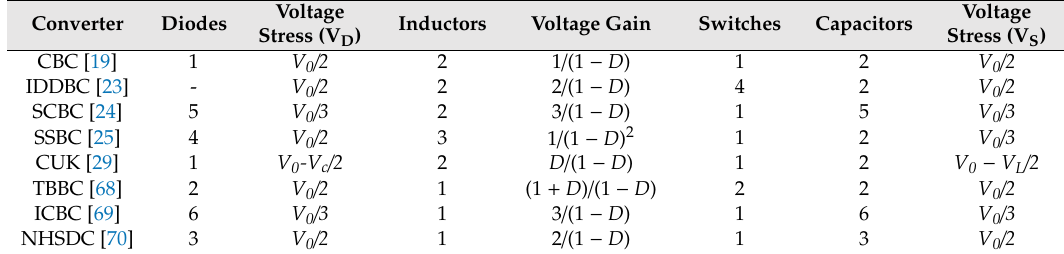
Table 4. Comparison of high step-up voltage DC-DC converters.